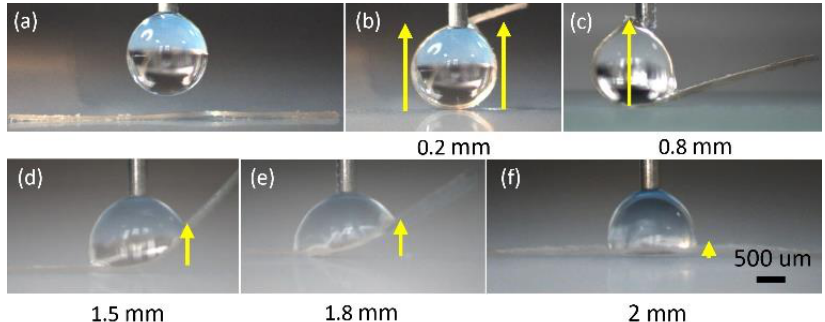
Figure 10. Deformation of the ribbon with different width. ( a ) A 1 µL droplet is dispensed at the middle of the ribbon; the ribbon with width of ( b ) 0.2 mm, ( c ) 0.8 mm, ( d ) 1.5 mm, ( e ) 1.8 mm, and ( f ) 2 mm bend. The deformation of the ribbon is highlighted with yellow arrow line.